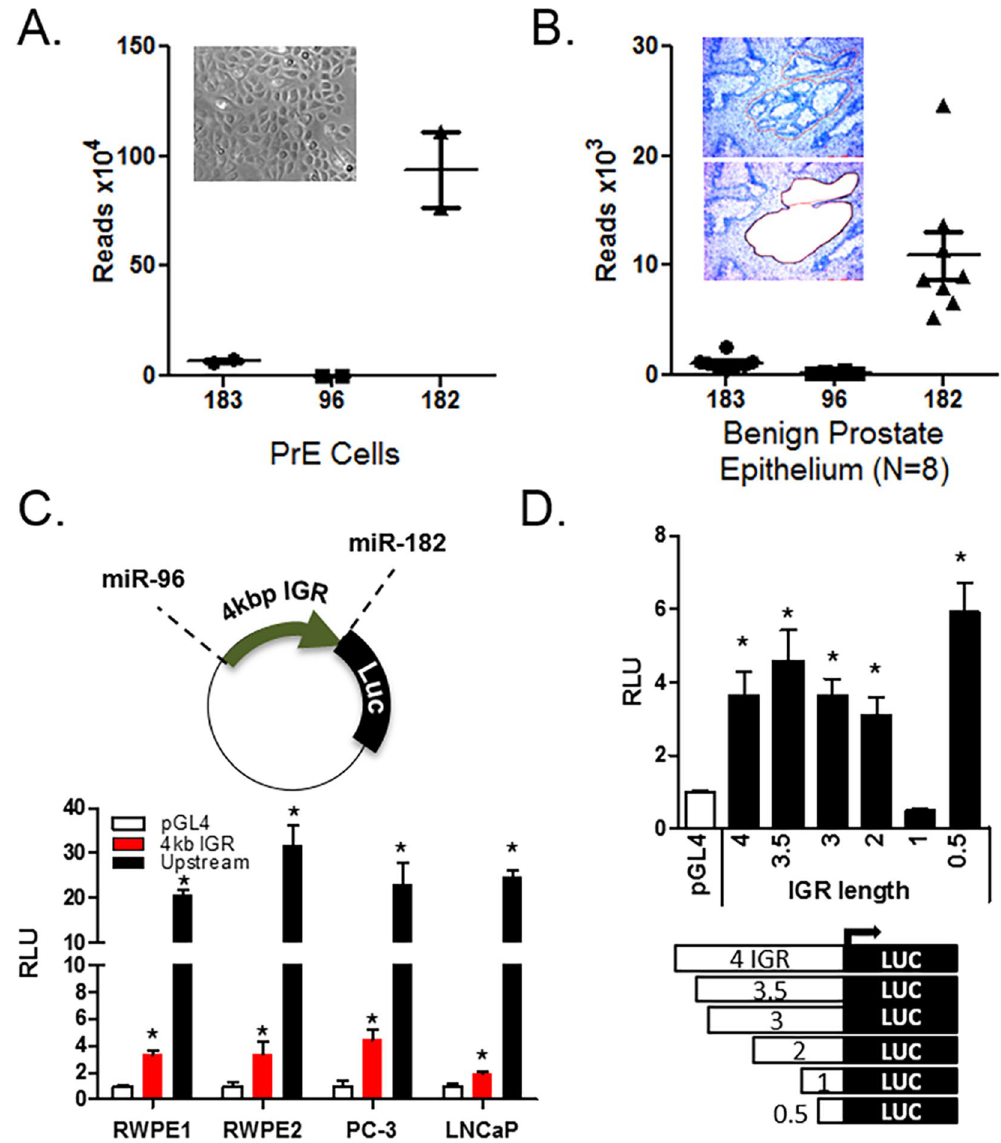
Figure 6. Intergenic region in the miR-183 cluster has a secondary transcriptional start site. Expression of the miR-183 family in benign prostate epithelial cells by Illumina RNAseq examined on the small RNA fraction ( < 50 bp) isolated from. ( A ) Primary prostate epithelial cells (PrE) (n = 2) and, ( B ) LCM-collected benign prostate epithelium from radical prostatectomy patients (n = 8). The miRs were normalized to raw reads. ( C ) Activity of a pGL4 luciferase plasmid with insertion of the intergenic region between miR-96 and -182 (IGR) as the promoter. IGR-luc in RWPE1, RWPE2, PC-3 and LNCaP prostate cell lines. pGL4 plasmid with 1 kb of the miR-183-upstream promoter included for comparison. n = 3 for each cell line. ( D ) The activity of IGR-luc deletion mutants in the RWPE1 cell line. Bar graph shows mean with SEM for n = 4. * p < 0.05 compared to pGL4 empty vector by Student’s paired 2-sided